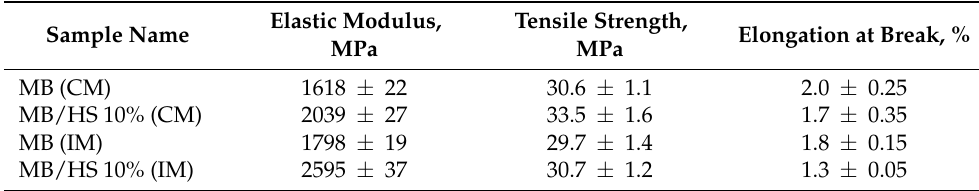
Table 3. Elastic modulus, tensile strength, and elongation at break of compression-molded and injection-molded MB and MB/HZ 10%